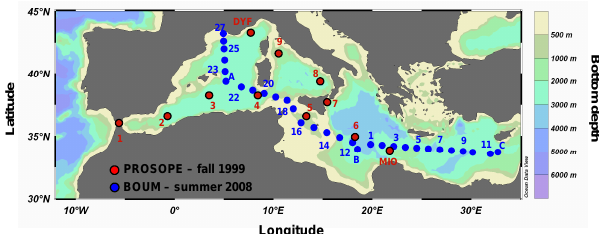
Fig. 1. Cruise tracks and sampling sites during the PROSOPE cruise in late summer/fall 1999 (red dots) and during the BOUM cruises in summer 2008 (blue